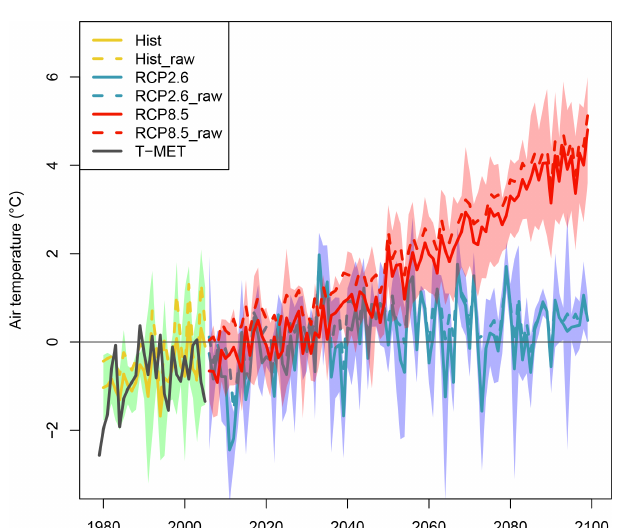
Figure 4. A point-scale TopoCLIM product: the mean annual near- surface air temperature at the Weissfluhjoch (2540ma.s.l.), show- ing corrected historical, RCP2.6, and RCP8.5 time series. T-MET and uncorrected CORDEX data are also shown for comparison. The coloured envelopes indicate the model spread and the ensemble mean is given by the bold line. The zero degree isotherm is given by the horizontal line.